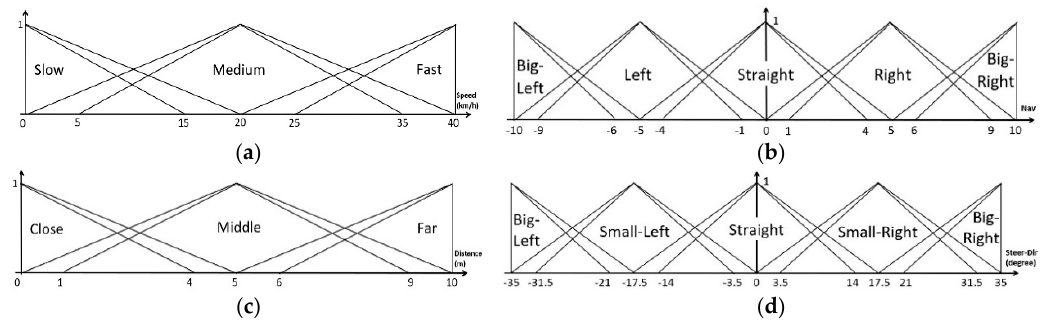
Figure 4. Membership function of ( a ) speed input; ( b ) navigation input; ( c ) distance input; and ( d ) steering direction output .